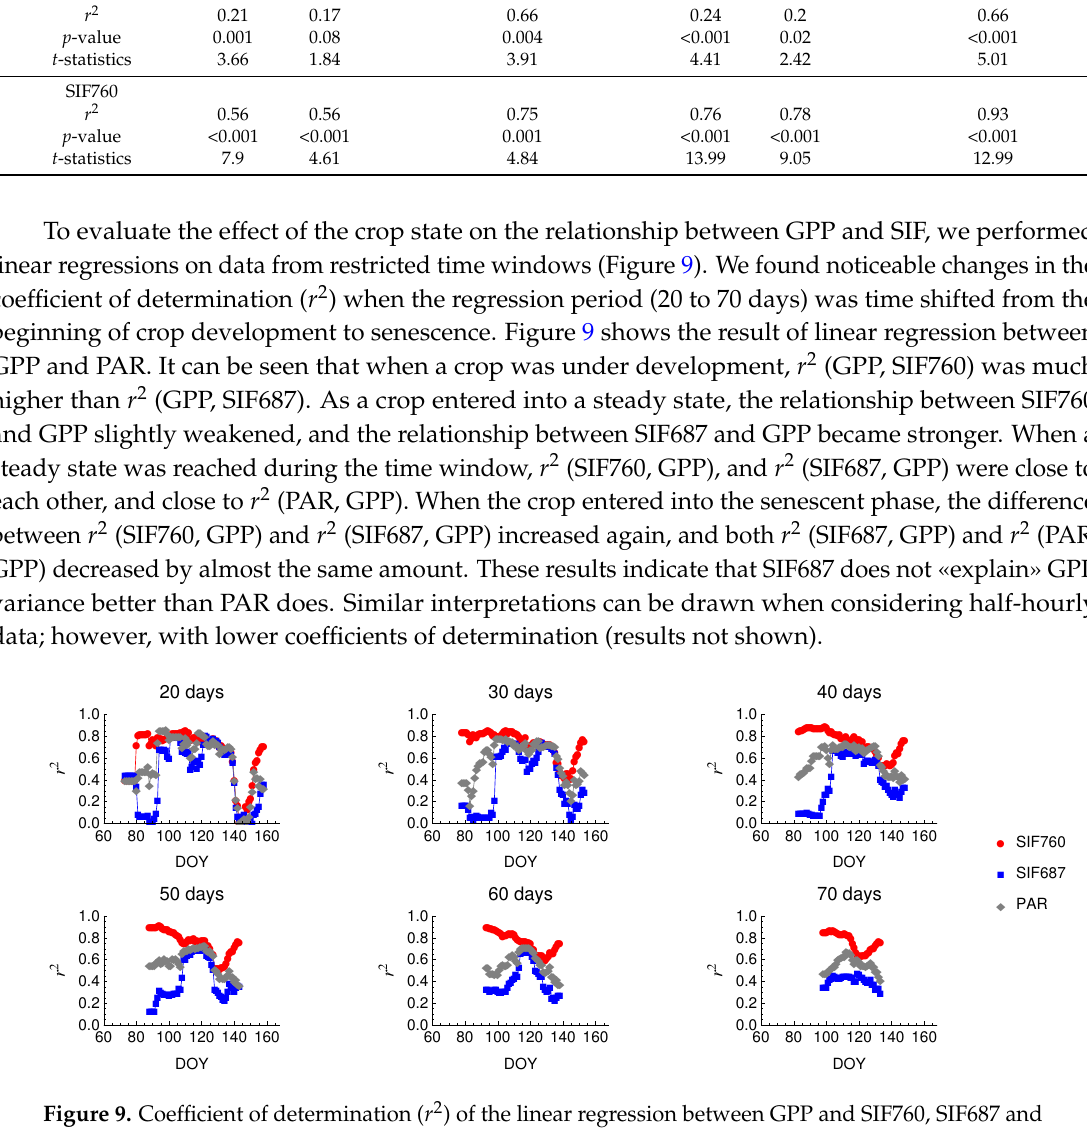
Figure 9. Coefficient of determination ( r 2 ) of the linear regression between GPP and SIF760, SIF687 and PAR for a moving time window (20, 30, 40, 50, 60, and 70 days). Linear regression was performed between daily averages from Figure 7c,d. DOY denotes the middle of the moving time